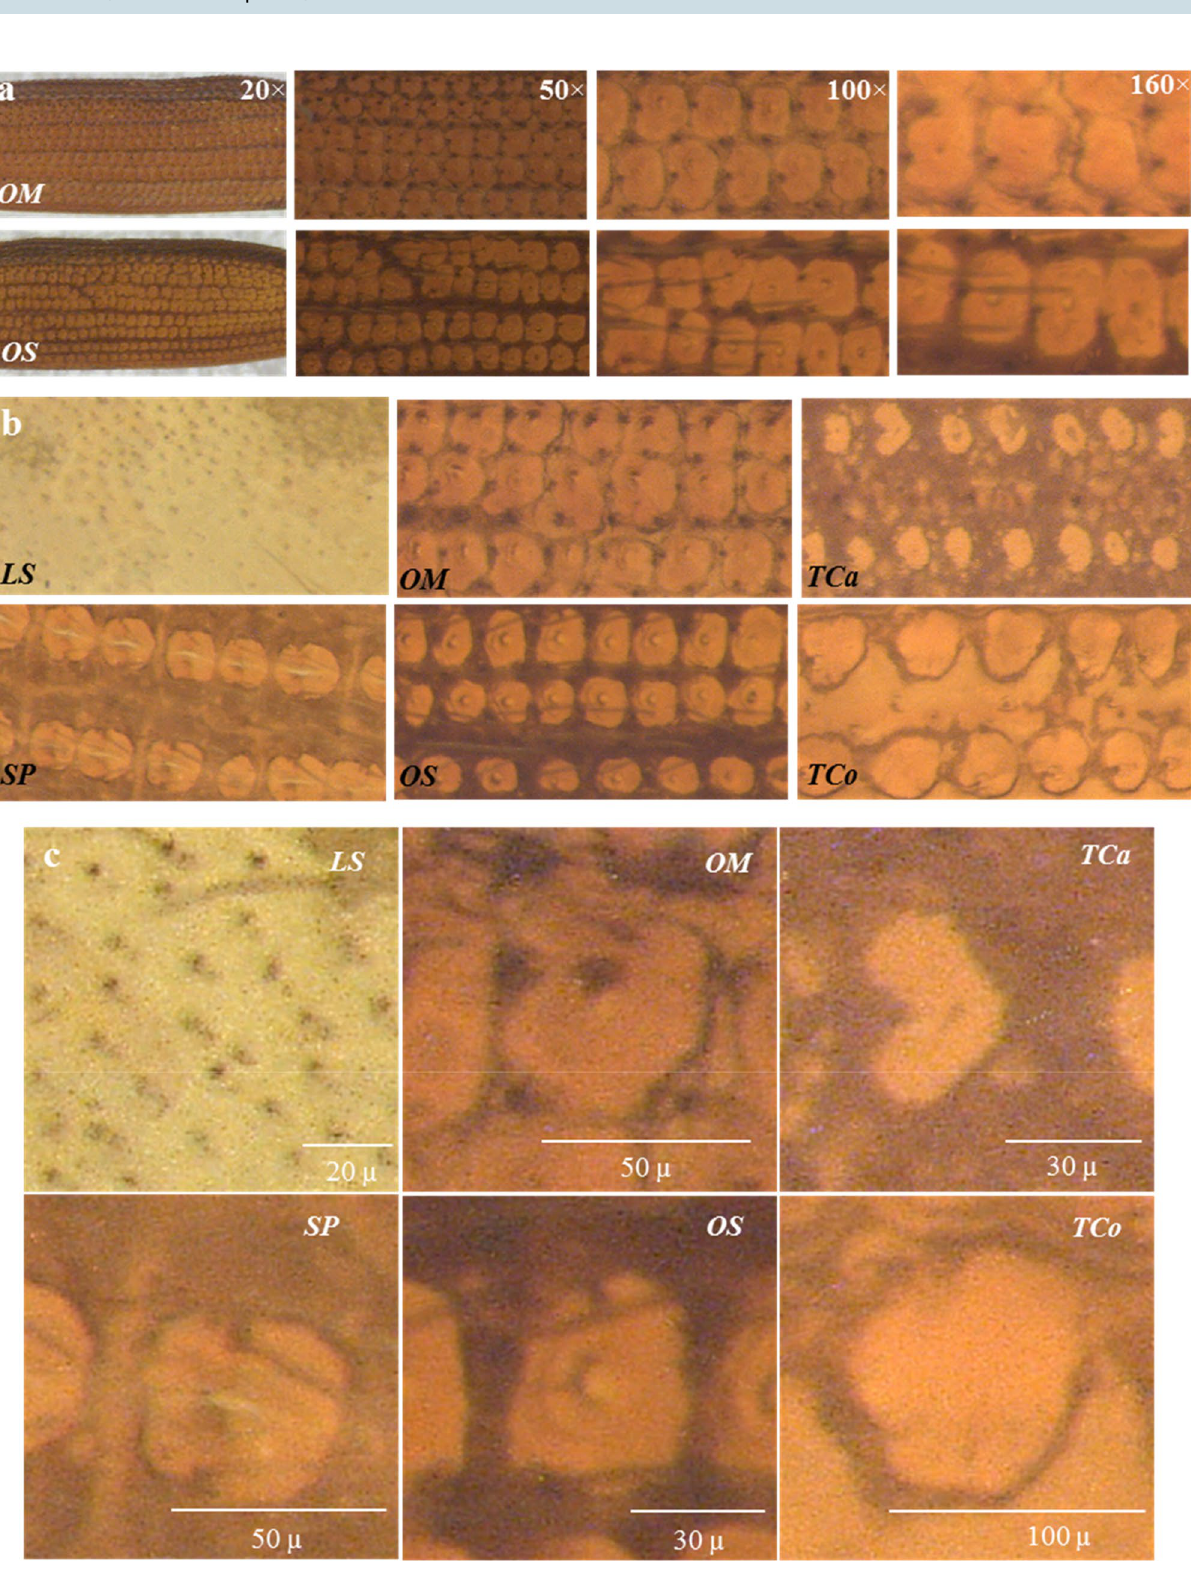
Figure 5. Elytra and their patterns at various magnifications; (a) elytral images of species O. mercator (OM) and O. surinamensis (OS) at magnifications 20x to 160x; (b) elytra patterns captured for six different species at 100x magnification under the Trans illumination system; and (c) various elytra patterns for the same six species at higher display resolution, which highlights that this setup ( Trans at 100x) is capable of resolving the finest pattern details required to distinguish species belonging to the same genus or family from one